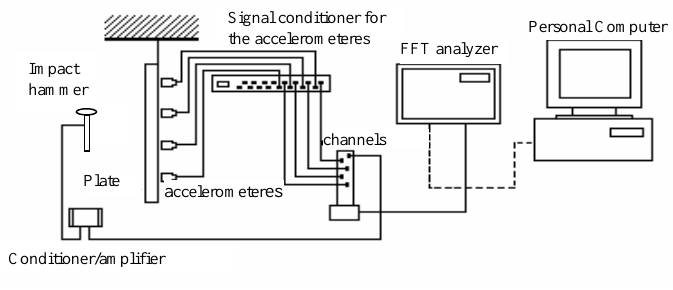
Fig. 1. The scheme of the experimental